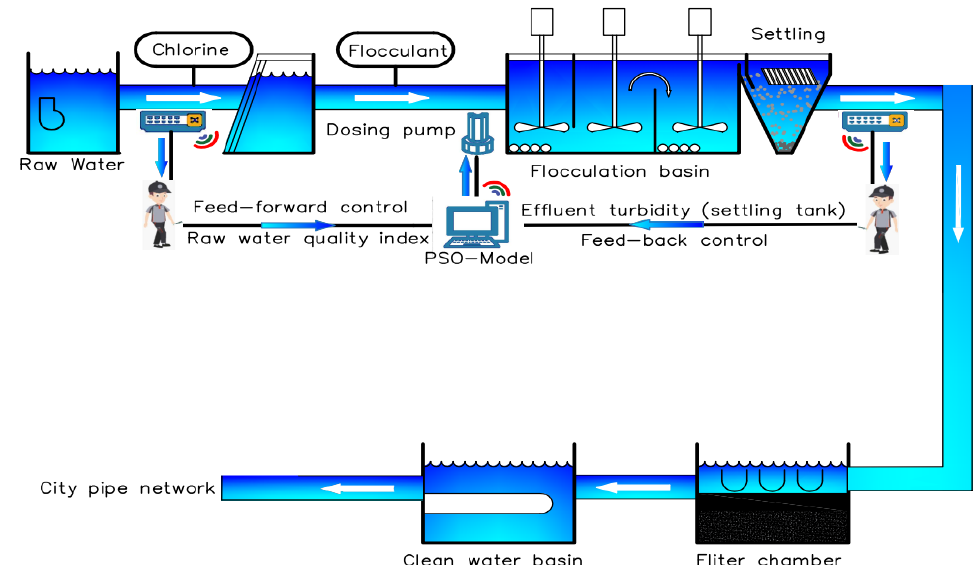
Figure 1. A controlling diagram of flocculant dosing in drinking water plant.